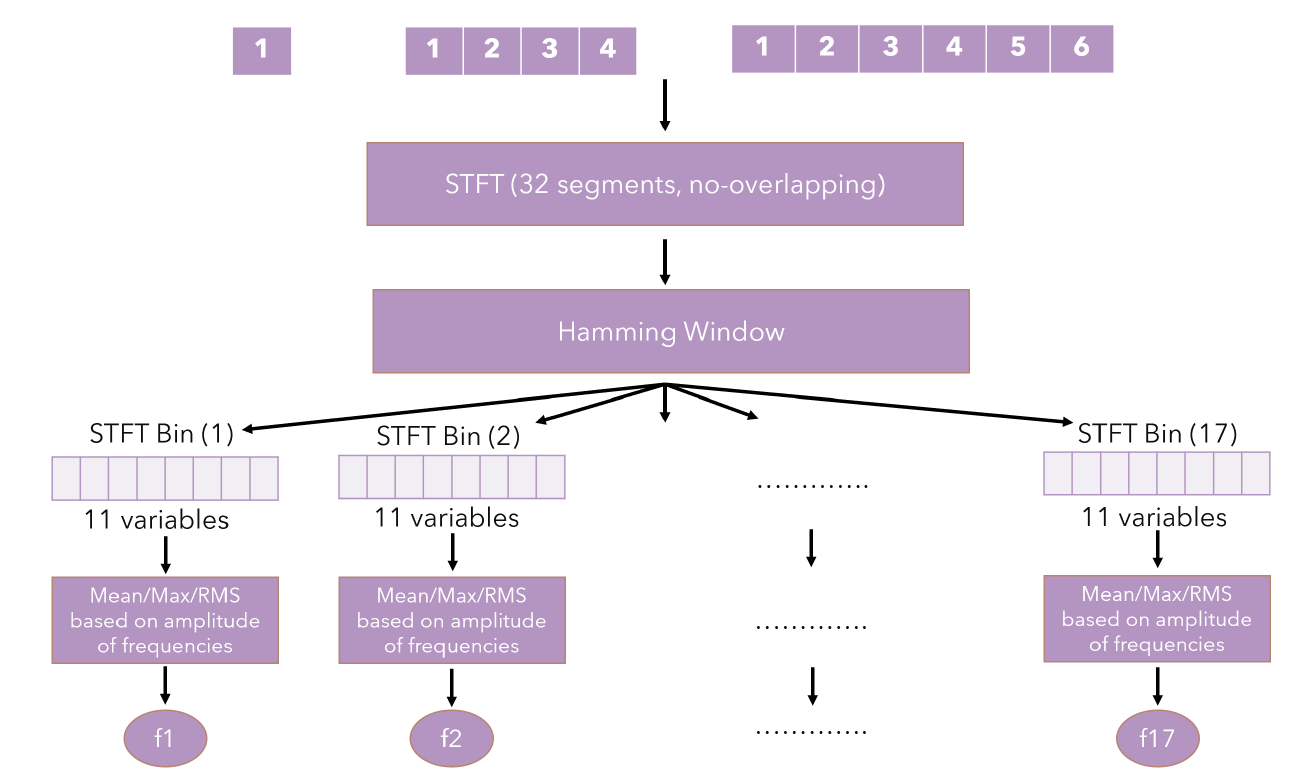
Figure 7. Feature generation flow